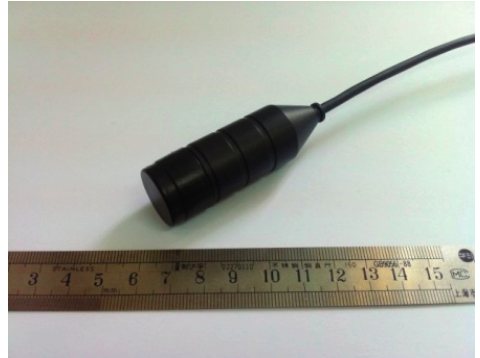
Figure 2. The PMN-PT single crystal-based TCD transducer.